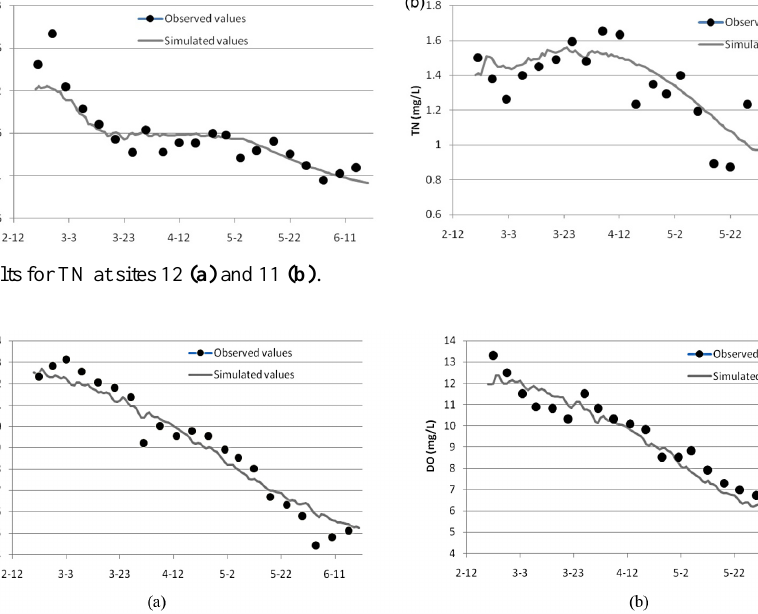
Figure 8. Calibration results for DO at sites 12 (a) and 11 (b) .